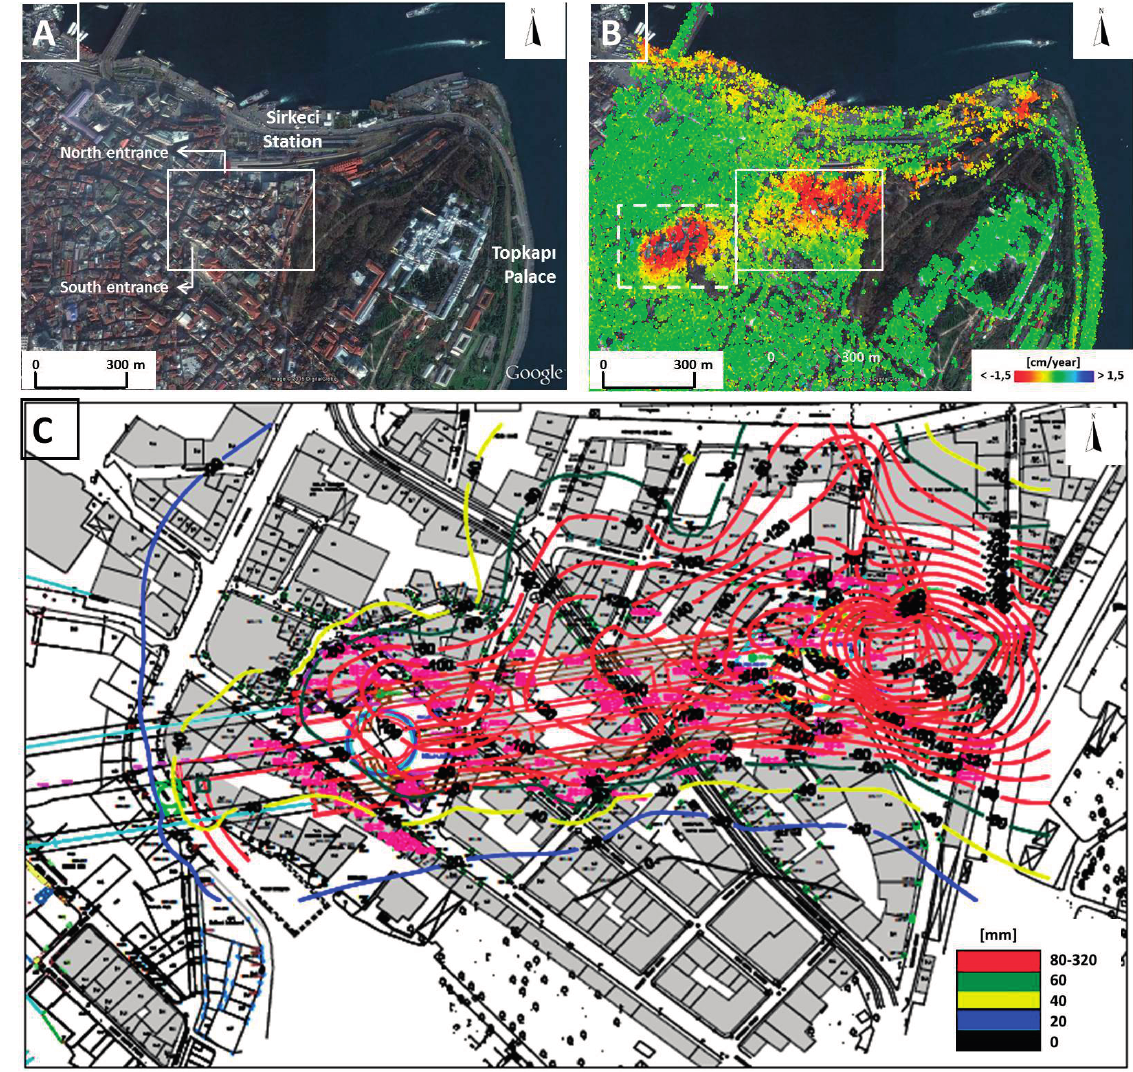
Figure 9. Comparison between SAR and levelling measurements. ( A ) Optical data related to the Sirkeci area. ( B ) Corresponding full resolution SBAS-DInSAR deformation velocity map. White continuous-line polygons in (A) and (B) show the area reported in ( C ). White dashed-line polygon in (B) shows excavation-triggered deformation area detected by DInSAR. (C) Map showing contour lines of cumulated displacements, retrieved from levelling measurements carried out between 10 May 2006 and 2 December 2013. For location of the area see